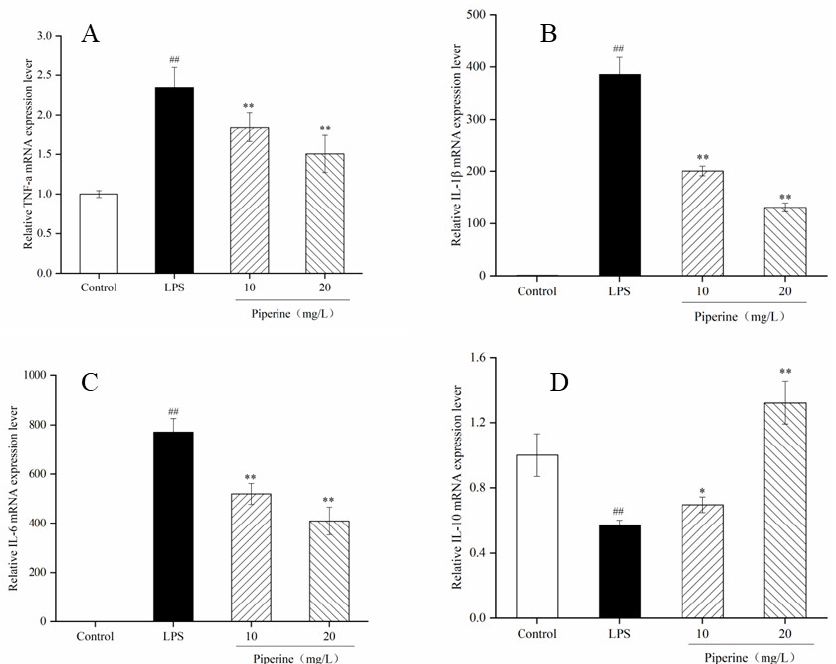
Figure 5. Piperine-inhibited LPS-stimulated TNF-α ( A ), IL-1β ( B ), IL-6 ( C ) and IL-10 ( D ) mRNA expression levels in RAW264.7 cells. Ave ± SD, ## p < 0.01 vs. control group; * p < 0.05 and ** p < 0.01 vs. LPS group.